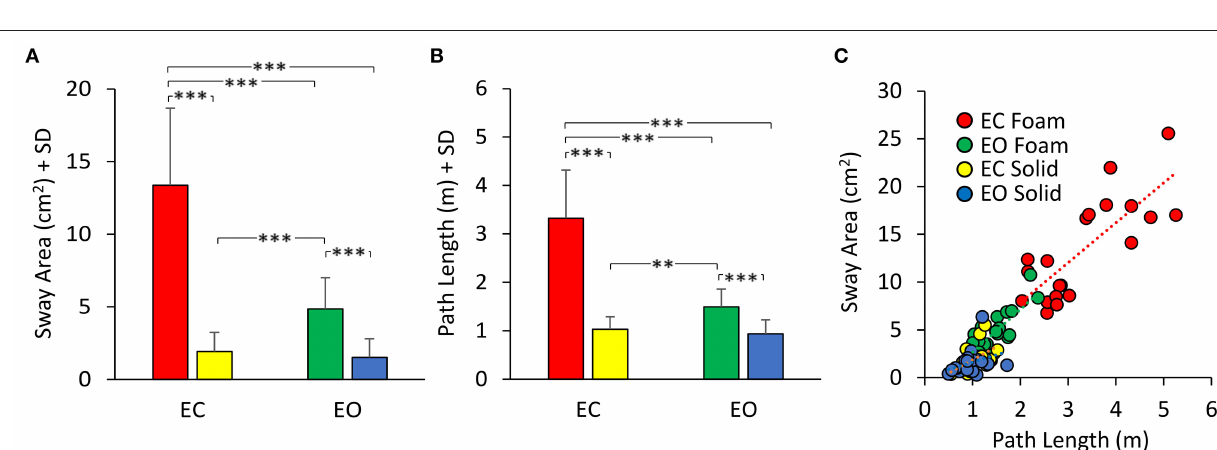
and EO conditions with Foam were similar. The determination coefficients were greater with Foam than Solid support, where they were small and barely or not